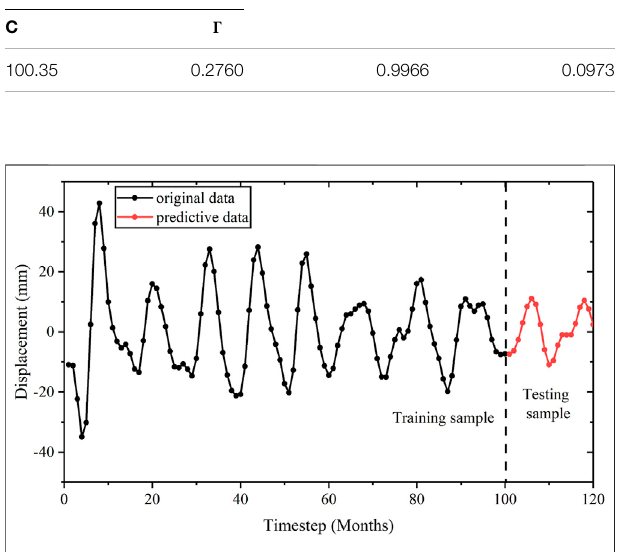
FIGURE 8 | Plot displaying the prediction of periodic